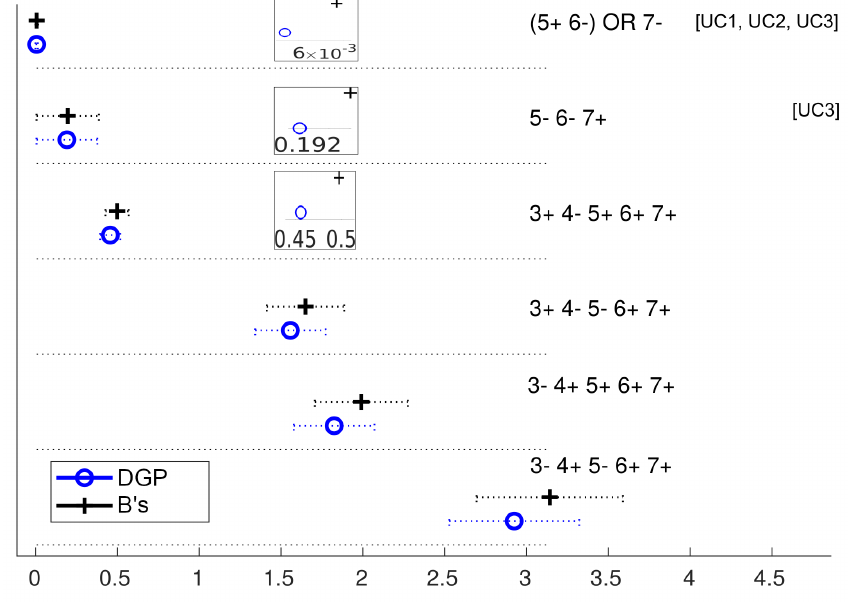
Figure A10. The six distinctive behaviours found in all scenarios for M 12 ( β R − uncert ) when α R (cid:54) = 1 (axes 3 and 4 must therefore be at different extreme positions), with zoom in those with more similar measure for both